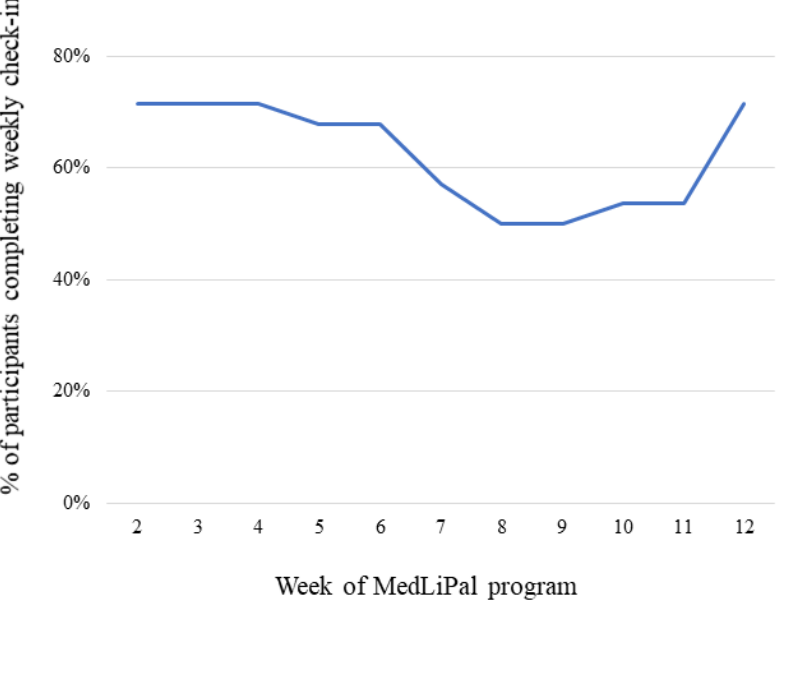
Figure 3. The percentage of participants completing the weekly virtual health coach check-in across the 12-week intervention